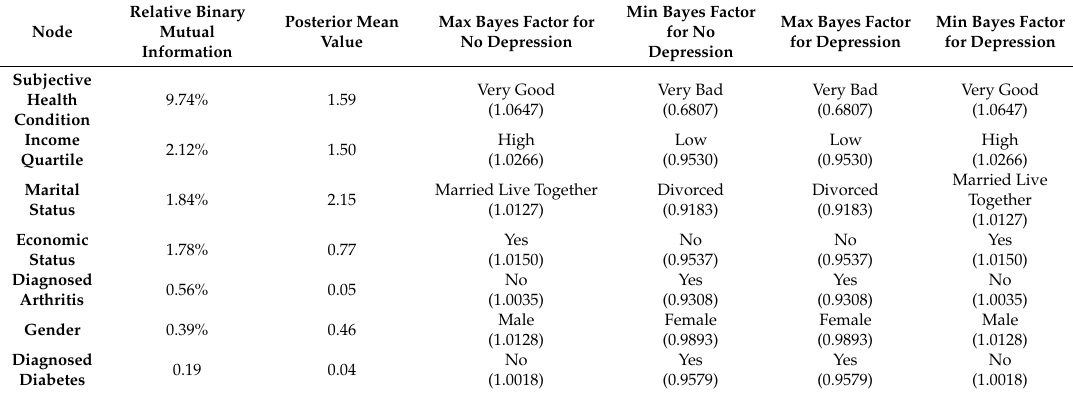
Figure 2. Variables selected with the Sons and Spouses machine learning algorithm and the connected nodes and arcs. As seen, marital status, economic status, income quartile, subjective health condition, gender, diagnosed with arthritis, and diagnosed with diabetes are direct child nodes of the target node depression. Table 1. Descriptive statistics from the Sons and Spouses network (target variable: depression).